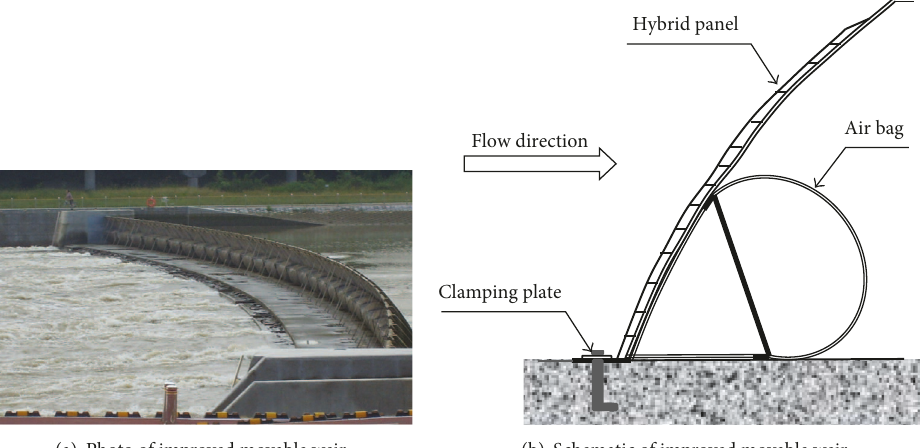
Figure 1: System of improved movable weir.